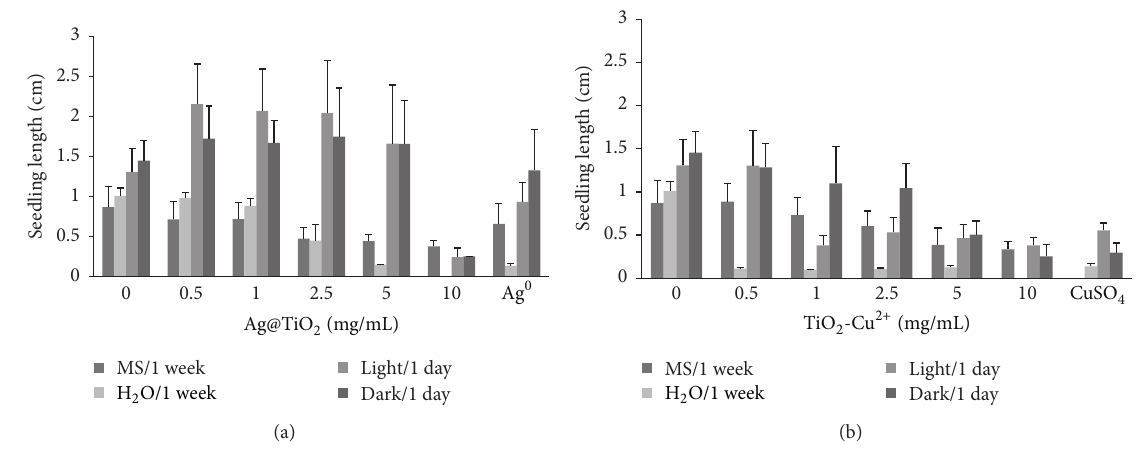
Figure 6: Seedlings elongation after exposure to NSMs: (a) Ag@TiO 2 and (b) TiO 2 -Cu 2+ . Columns represent the mean and the bars represent ± one standard deviation; 𝑛 = 10